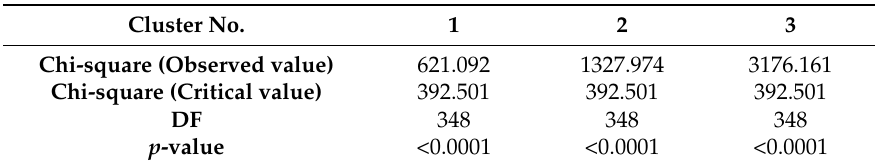
Table 6. Chi-square distance tests of association between samples and terms from the CATA question for all three clusters. A level of significance α = 0.05 was used. Cluster